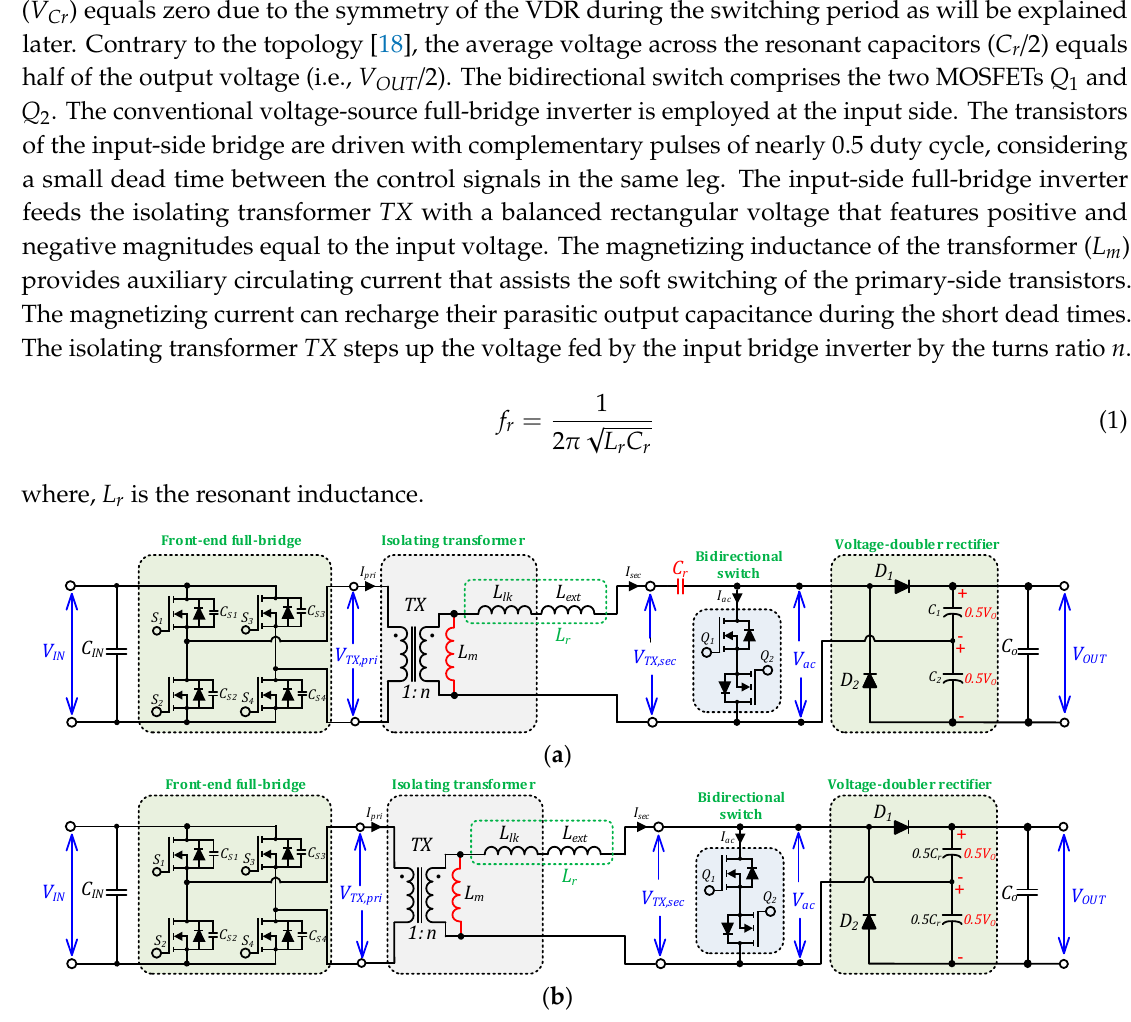
Figure 1. Converter topology of ( a ) the proposed SRC based on the modified VDR with a bidirectional switch and ( b ) the SRC presented in [18].